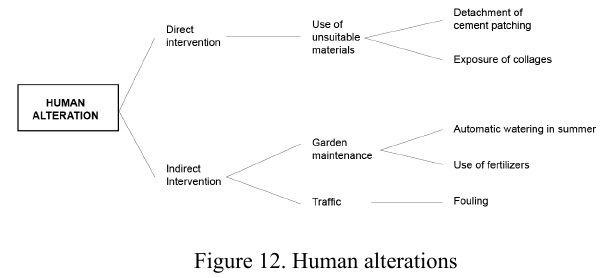
Figure 12. Human alterations